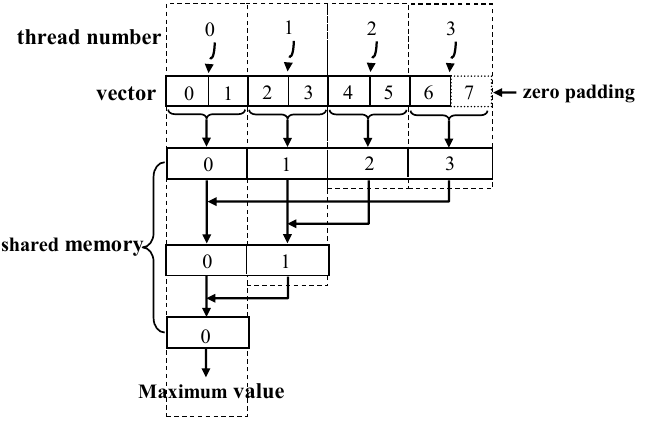
Figure 7. Model diagram of the point vector adaptive reduction parallel